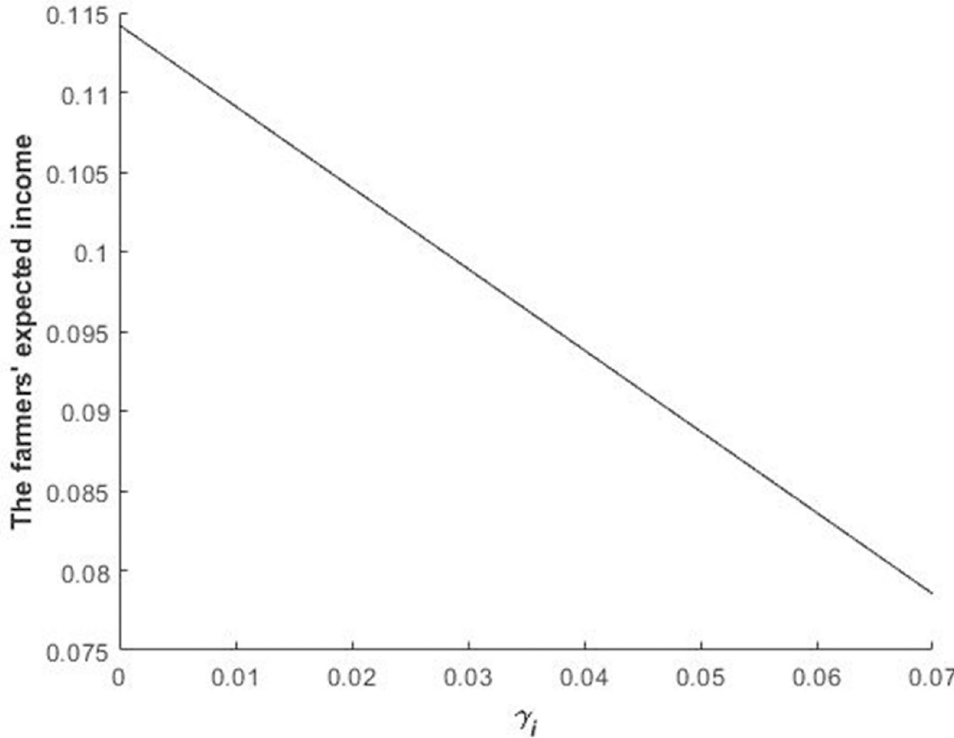
Fig 6. Impact of γ